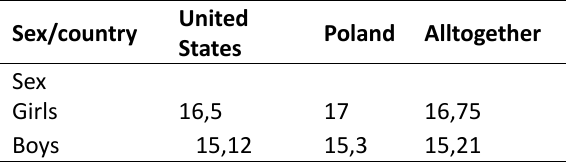
Table 2. Average age of respondents by sex (gender)